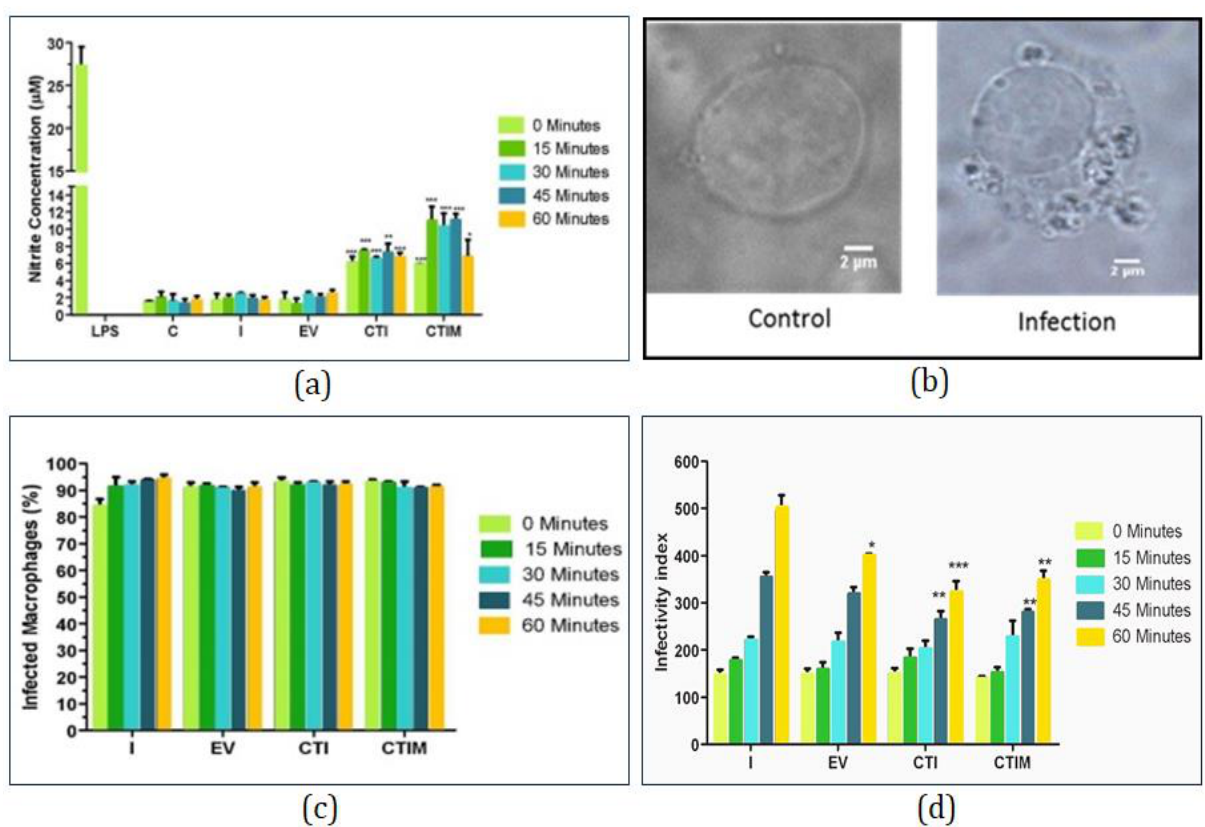
Figure 9. In vitro validation of designed synthetic circuit: ( a ) Nitrite estimation for various groups post one hour of infection in comparison with LPS treatment. ( b ) Microscopic image (100 × ) of control and infected RAW264.7 macrophage. ( c ) The percentage of macrophages infected with L. major parasite. ( d ) Estimation of parasite burden in terms of infectivity index in various infected and transfected groups. The experiments were performed thrice. One way ANOVA (with Tukey’s correction) have been used to perform statistical analysis of Infectivity index and student t- test have been used to analyze Nitric oxide estimation The error bars represents mean ± SD with p value * p < 0.05, ** p < 0.01, *** p < 0.001.